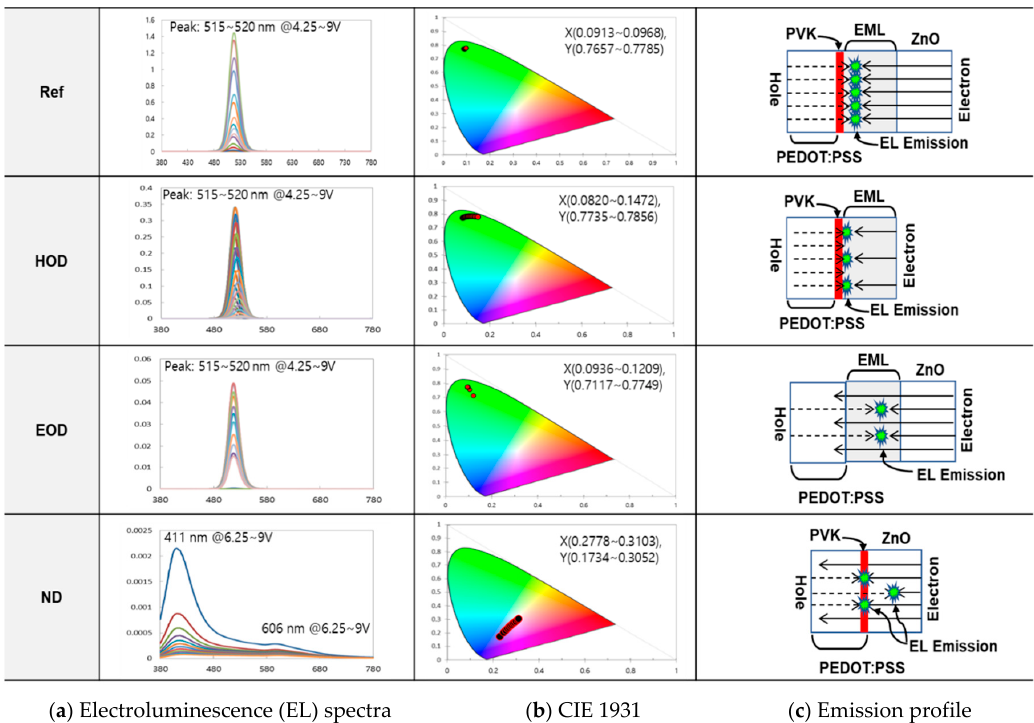
Figure 3. A step for the emission profiling study for characterizing the charge flow through the layers consisting of the newly proposed QD-LEDs: the first, second, and third columns represent the Electroluminescence (EL) spectra, the Commission internationale de l’ éclairage (CIE) 1931 chart, and the emission profile, respectively, for the various test samples. ( a ) is the measurement of the electroluminescence according to the voltage, and the emission color can be predicted from the peak value. ( b ) is a diagram that defines the wavelength distribution of the electromagnetic visible spectrum and the color perceived physiologically in human color vision. ( c ) shows the position where electrons and holes from the electrode move to the emission layer to form electron hole pairs and emit light through recombination. Ref, HOD, EOD, and ND are the abbreviations for the reference devices, the hole only devices, the electron only devices, and the devices without QDs, respectively. Note that the structure of HOD was the same as Ref except the ZnO layer that acts as both ETL and HBL. On the other hand, the structure of EOD was the same as Ref except the PVK layer that acts as both HTL and EBL. Using these schemes, we can study the roles of PVK and ZnO in the emission profile via the exciton formation. Where, Ref, HOD, EOD, and ND are the abbreviations for reference, hole only device, electron only device, and no-QD device, respectively.